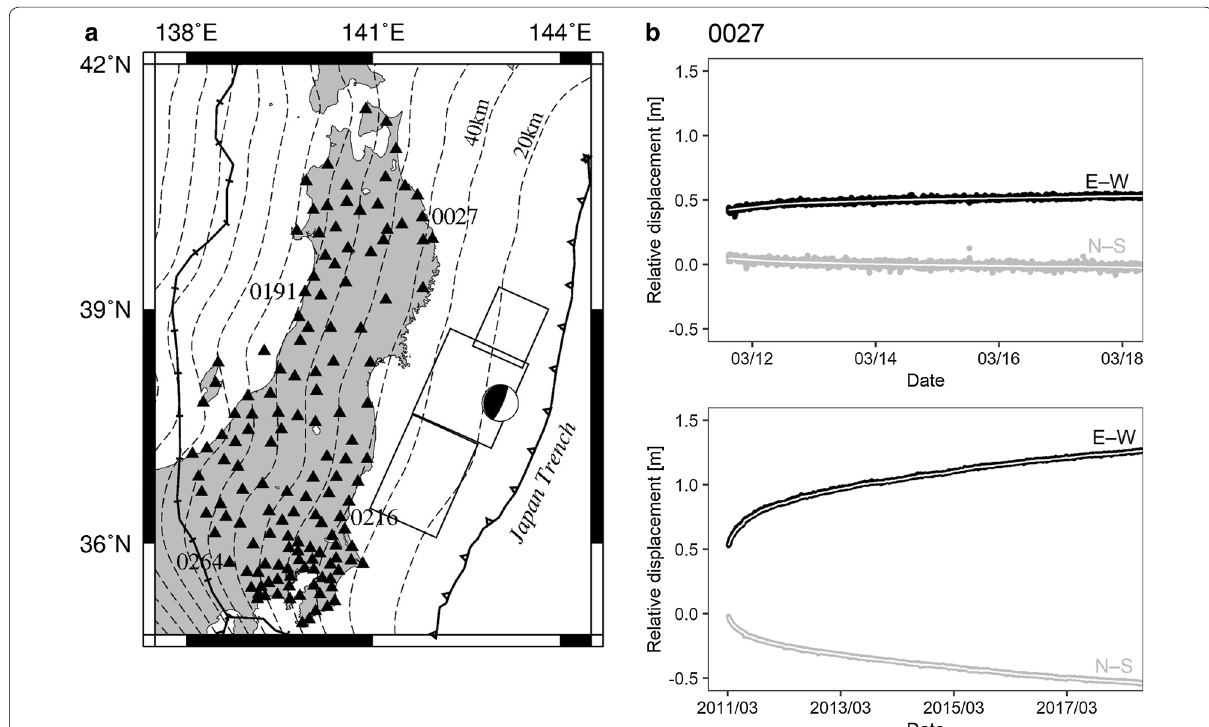
Fig. 1 a Locations of the 141 GEONET stations (solid triangles) used in this study, relative to the 2011 Tohoku megathrust earthquake and subducting plate interface. The study is focused in northeastern Japan, where the Pacific Plate subducts beneath the Okhotsk Plate at the Japan Trench. The beach-ball symbol indicates the centroid moment tensor solution of the 2011 Tohoku megathrust earthquake obtained by JMA (Japan Meteorological Agency), and the squares delineate the inferred fault ruptures from a coseismic fault model (Nishimura et al. 2011). The solid lines represent the plate boundaries (Bird 2003). The dashed lines represent the plate interface contours (Hayes et al. 2012) at 20 km intervals. b Example of the time-series data at the Kuji GEONET station, numbered 0027 on the map. The white lines represent the smoothed results. Both the 30-s sampling high-rate data (upper figure) and daily data (lower figure) following the mainshock are